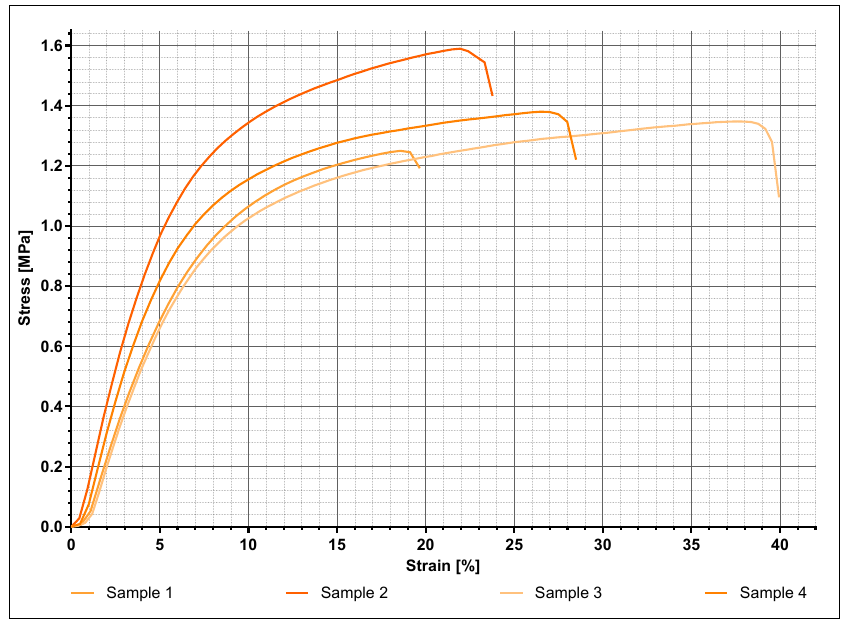
Figure 5. Stress–strain curves of four different SF10 samples. The varying starting points of the curves are related to measurements without preload, since travel in relation to clamping may partly be measured without force.